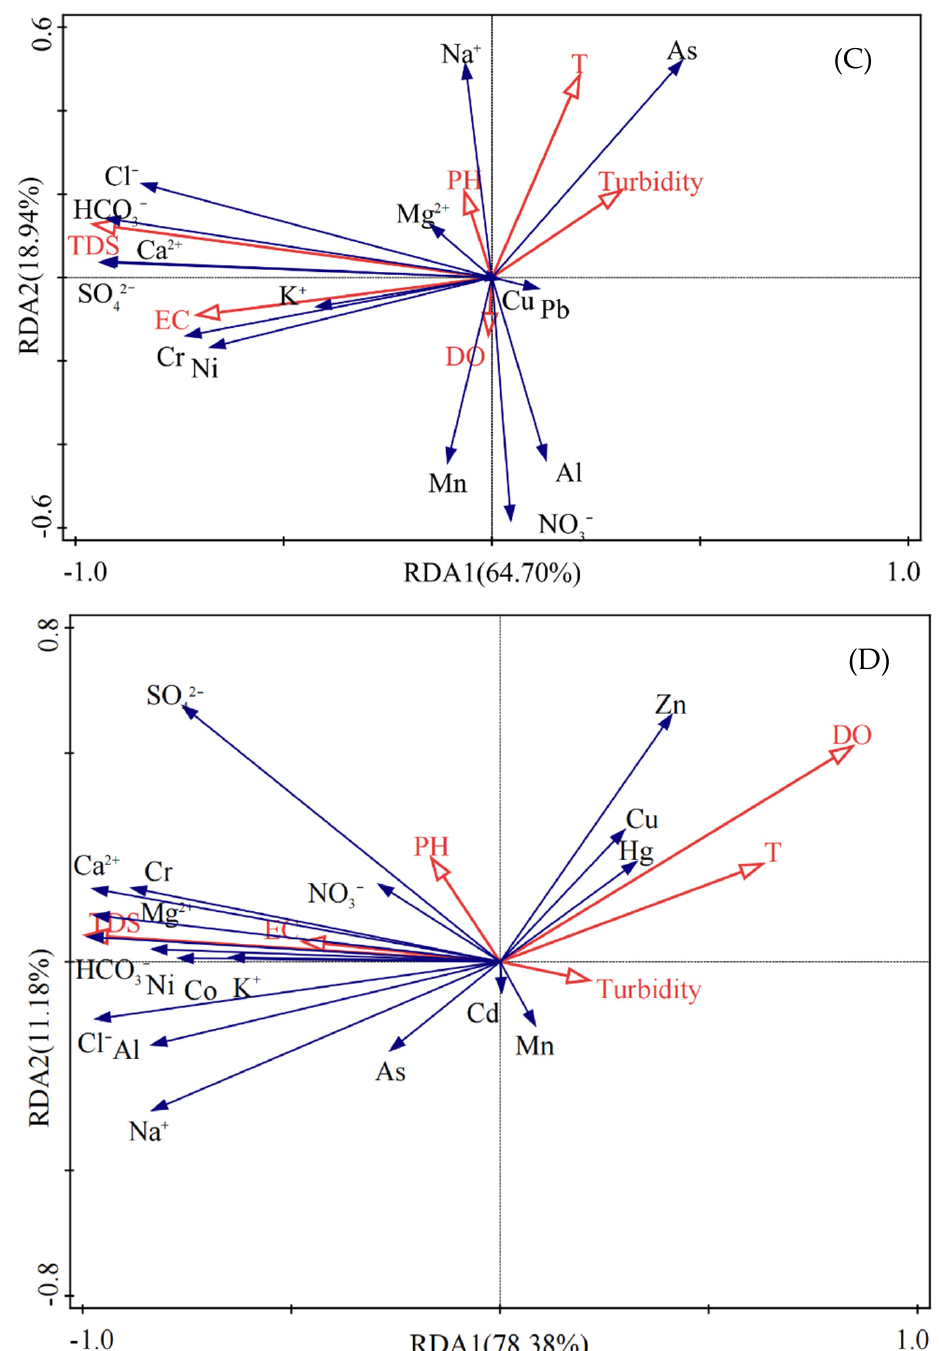
Figure 6. Influencing factors for selected parameters analyzed in the water samples collected from the Liujiang River in the wet season ( A , C ) and dry season ( B , D ) in China.